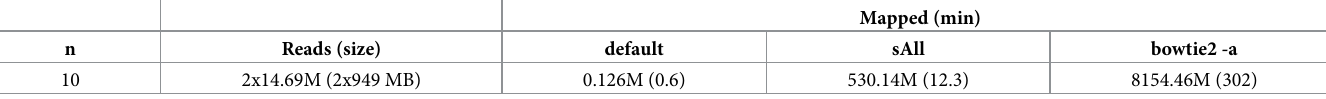
The CHIC aligner with Bowtie2 was run with three different parameter settings: default to find primary matches only, -sALL to find primary+secondary matches, and bowtie2 -a option (reports all approximate alignments) to find primary+secondary matches also from approximate read